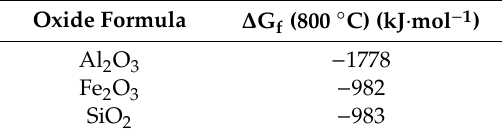
Table 7. Gibbs energy ( ∆ G f ) of formation of oxides at 800 ◦ C (calculated on the basis of published data [47]). Oxide